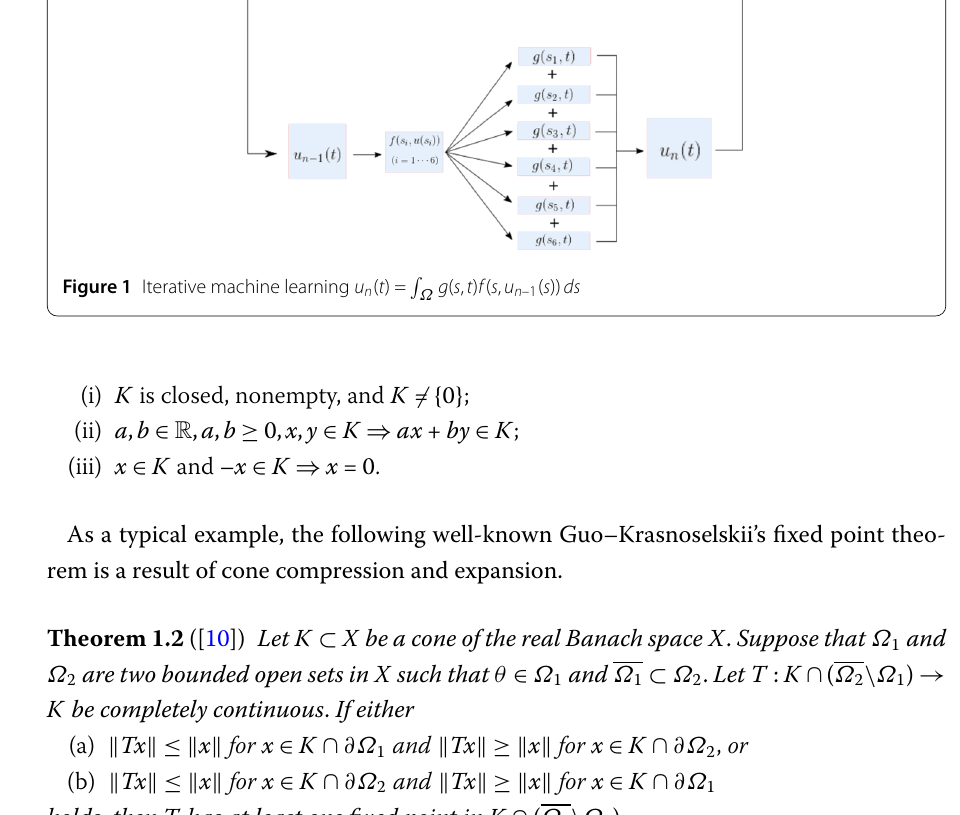
Figure 1 Iterative machine learning u n ( t ) =